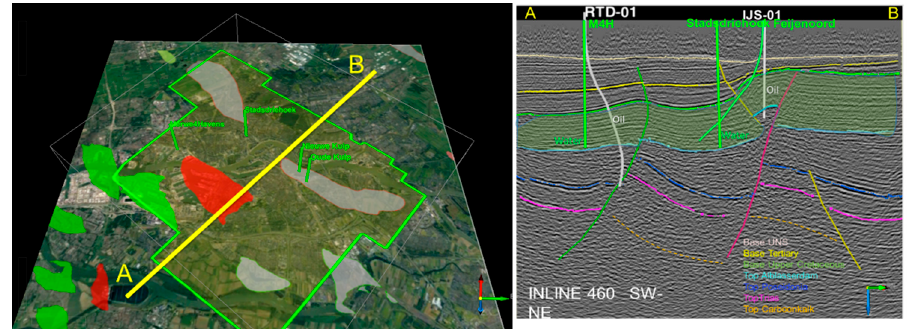
Figure 1. A 2D seismic profile of the subsurface under the studied area. Retrieved from van Campenhout [29]. Table 1. Geothermal source production characteristics. Retrieved from van Campenhout